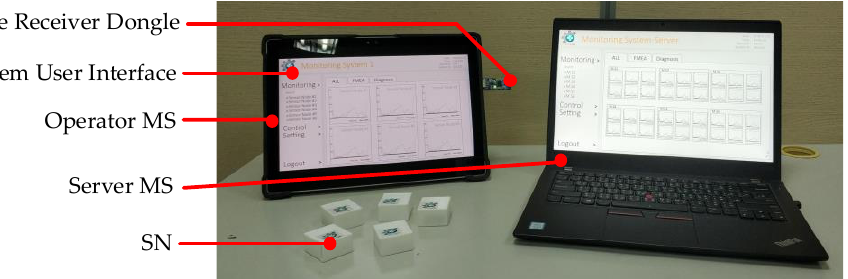
Figure 8. The photograph of the proposed system .